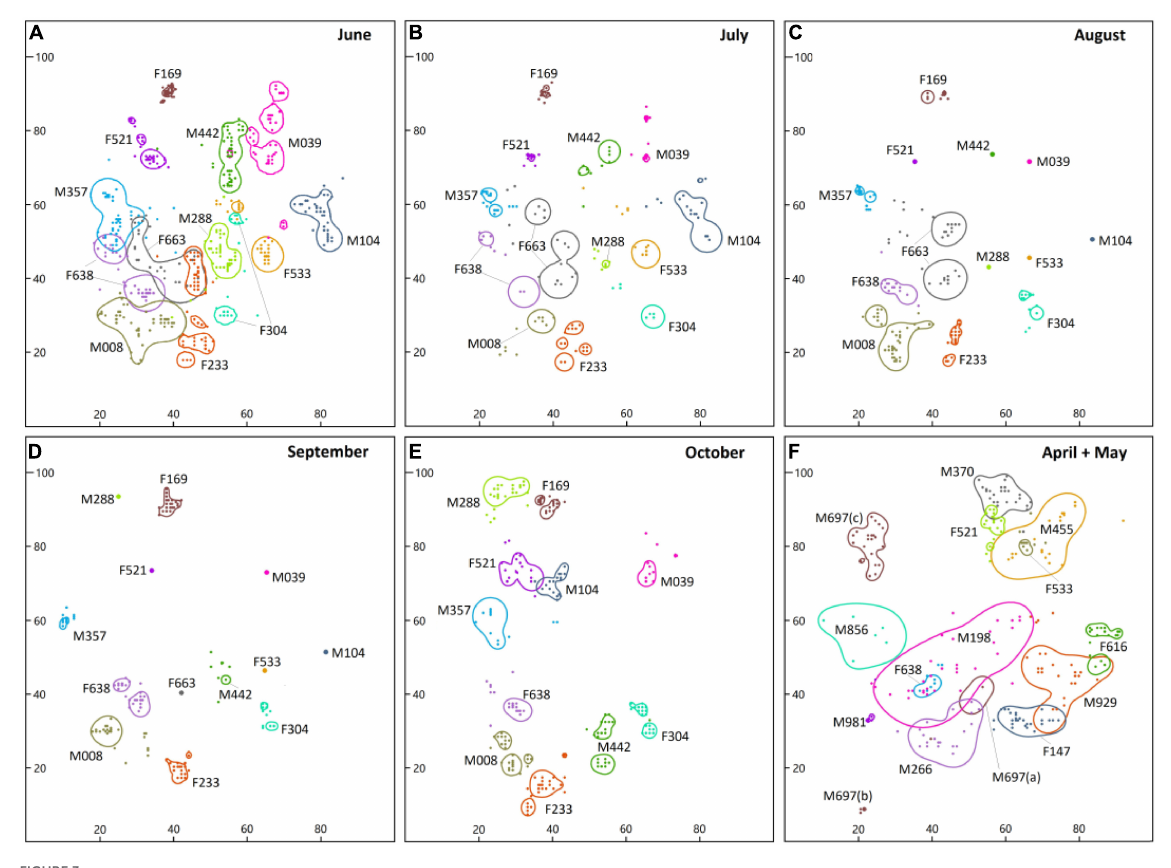
FIGURE3 Representation of the size of the home range of radio-tracked Myospalax baileyi in an alpine meadow in eastern Qilian Mountain estimated by 95% KDE methods. Maps (A–E) show the continuous home ranges in 2016 ( n = 13), whereas map (F) represents the home ranges of recaptured individuals in 2017 ( n = 13). The area of the same color in a single month represents the home-range of one zokor. Coordinate axis units are